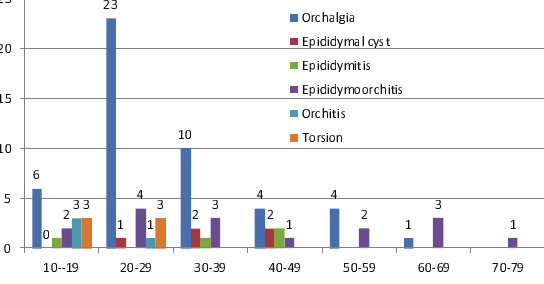
Figure 1: Distribution of patients with scrotal pain